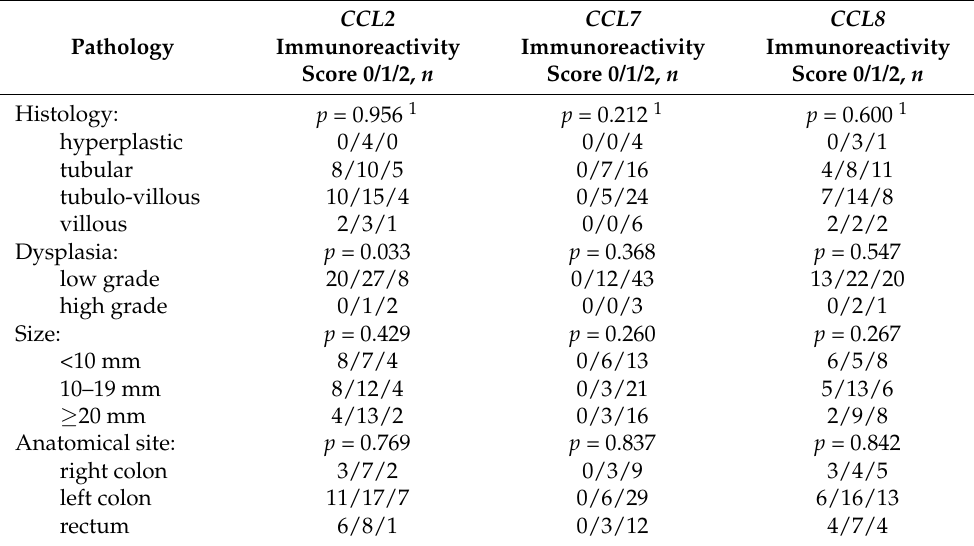
Table 2. Association of polyp CCL2 , CCL7 , and CCL8 expression with polyp